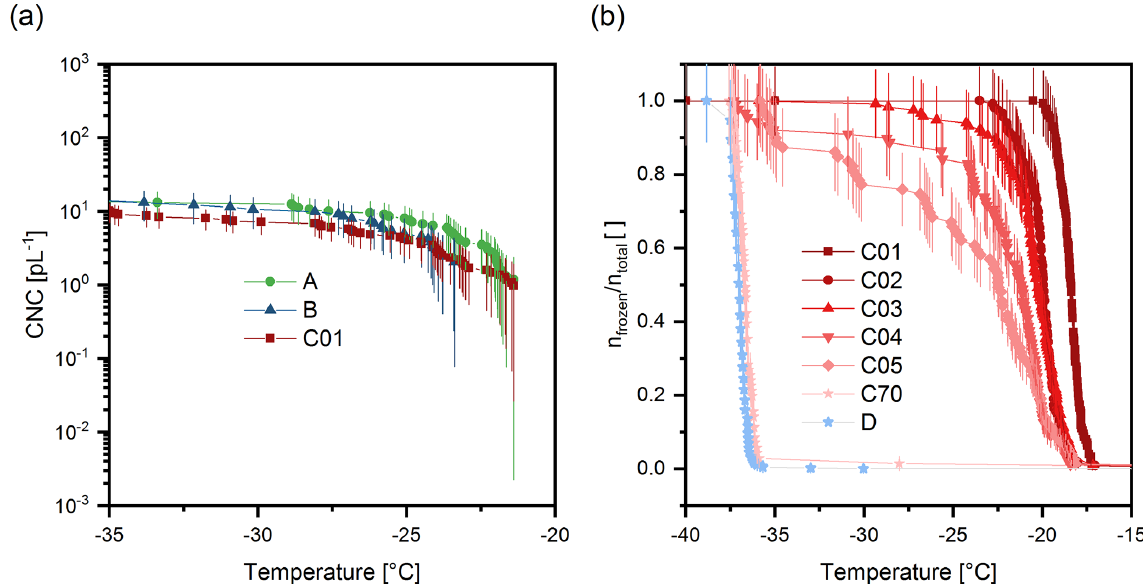
Figure 6. Ice nucleation spectra of extracted samples. (a) Cumulative ice nucleus spectra of samples A, B, and C01. Error bars correspond to the Gauss error propagation. (b) Freezing spectra of SPP washing solutions (C01, 1mL water used to wash SPPs, C02, second 1mL fraction, etc.) and of the purified SPPs (D). Vertical lines correspond to the counting error. The temperature uncertainty of VODCA is 0.5 ◦ C.